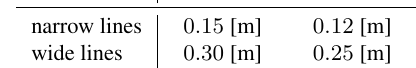
Figure 1. The work flow